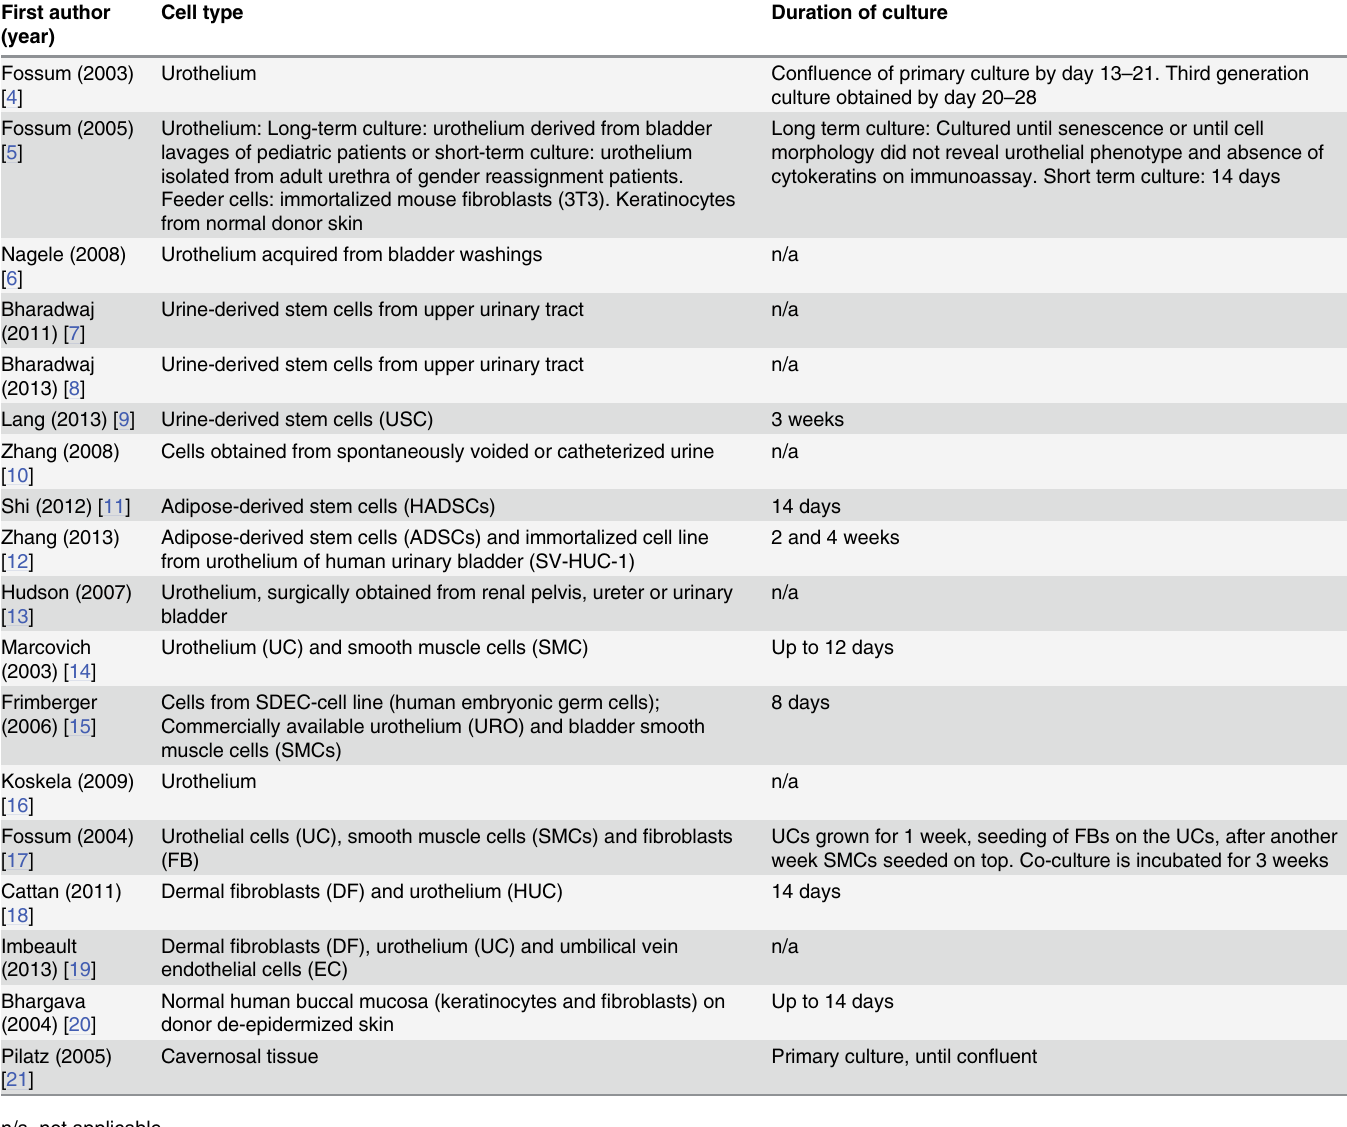
Table 1. Studies investigating autologous cells (n =